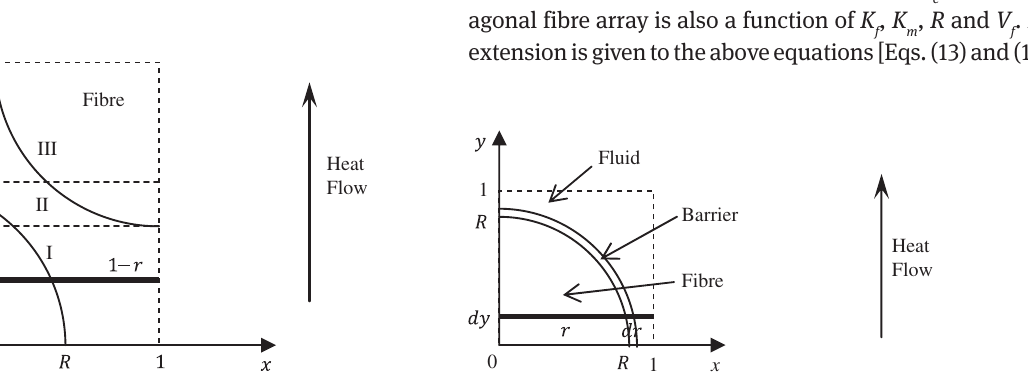
Figure 5 Heat flow in a quadratic unit cell with a thermal barrier on the fibre